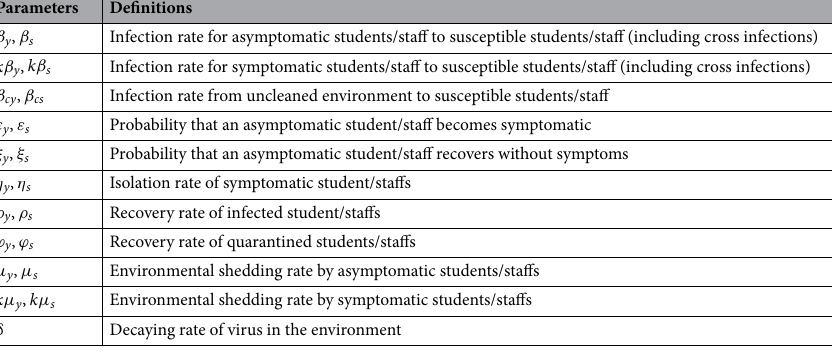
Table 1. Model parameter